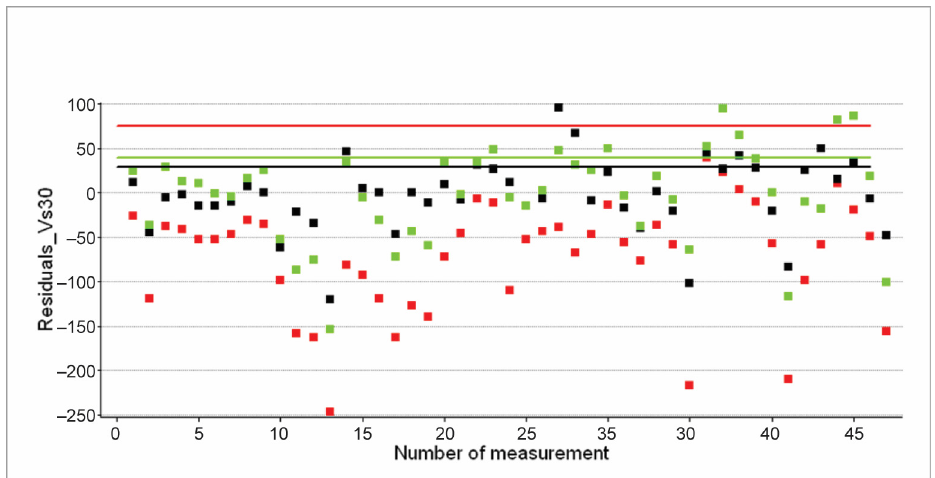
Figure 10. Comparison of residuals at the sampling points for the correlations obtained in Almeria city: MD1 (red points), MD2 (green points) and MD3 (black points).